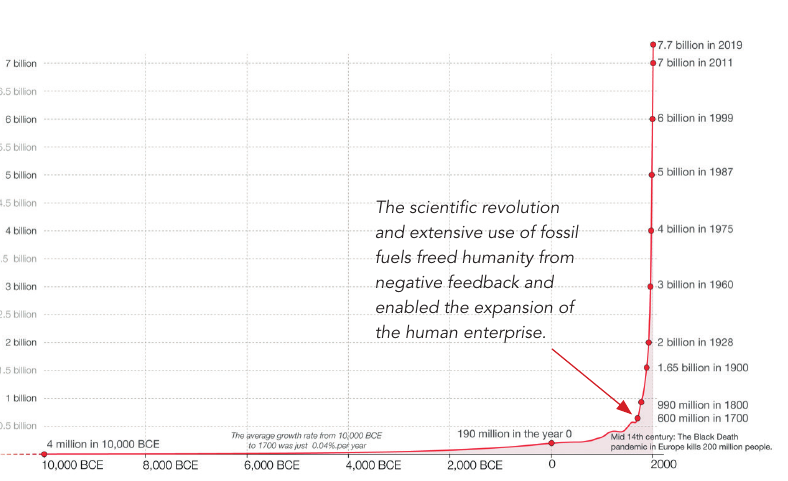
Figure 3: Human population over the past 12,000 years (what goes up will come down)